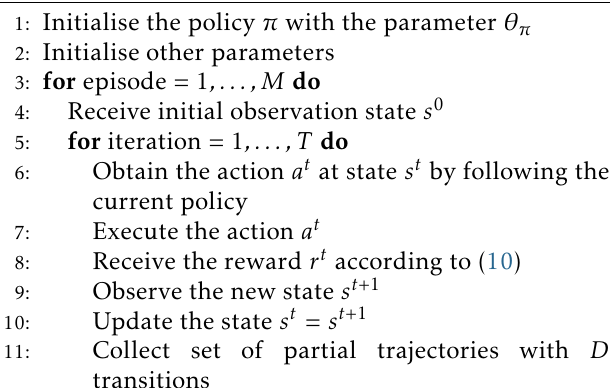
Algorithm 1 Proposed approach based on the PPO algorithm for the IRS-assisted D2D communications.